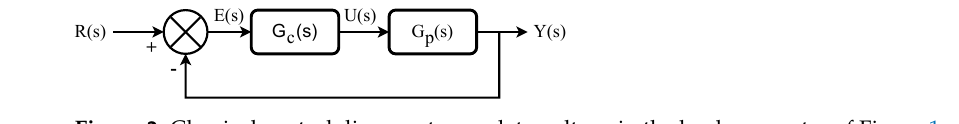
Figure 2. Classical control diagram to regulate voltage in the buck converter of Figure 1. By analyzing buck converter transfer function (2) one can determine that the system is of minimum phase since it does not presents right-half plane zeros or poles. The latter can be corroborate through the frequency response of buck converter shown in Figure 3, where no additional phase contribution from zeros or poles can be corroborated and a plant phase φ p = − 157.3 ◦ in open loop with no control effort is determined.